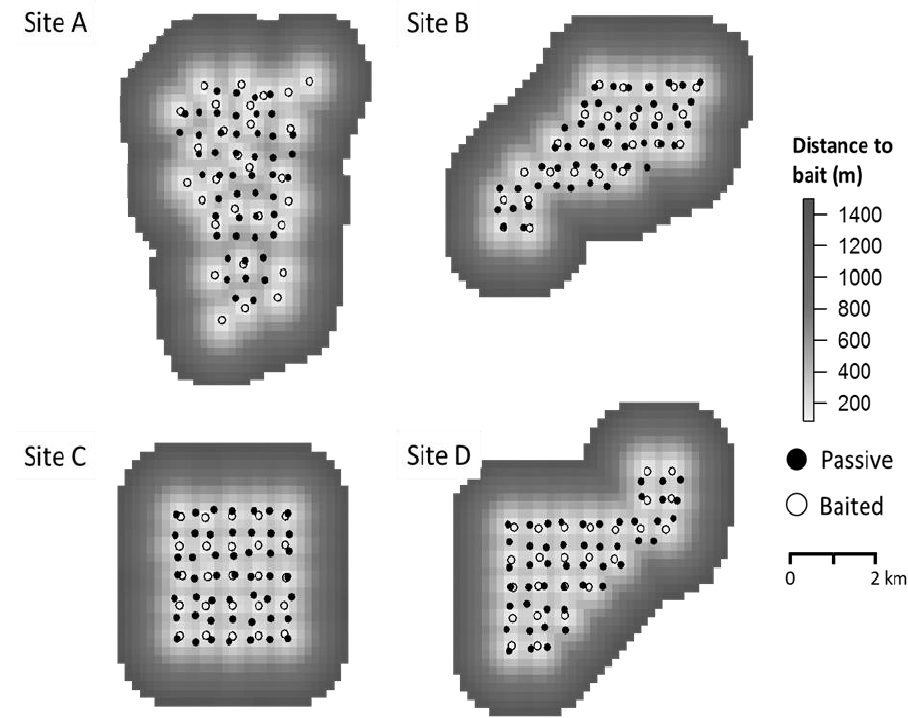
Figure 2. Raster density surfaces of each site ( A – D ) located in southwestern Georgia, USA, indicating distance from the spatial covariate, bait. Cameras were operated in the summer of 2015 and winter of 2016 to evaluate the effects of bait on male white-tailed deer ( Odocoileus virginianus ) resource selection. Open circles represent baited cameras and closed circles represent passive cameras.